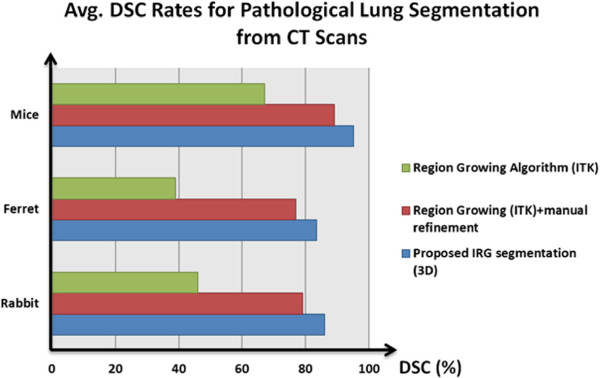
Average DSC rates for pathological lung segmentation from CT scans. Average DSC rates for pathological lung segmentation results are given in comparison with frequently used region growing algorithm (from ITK repository), with and without using manual refinements.